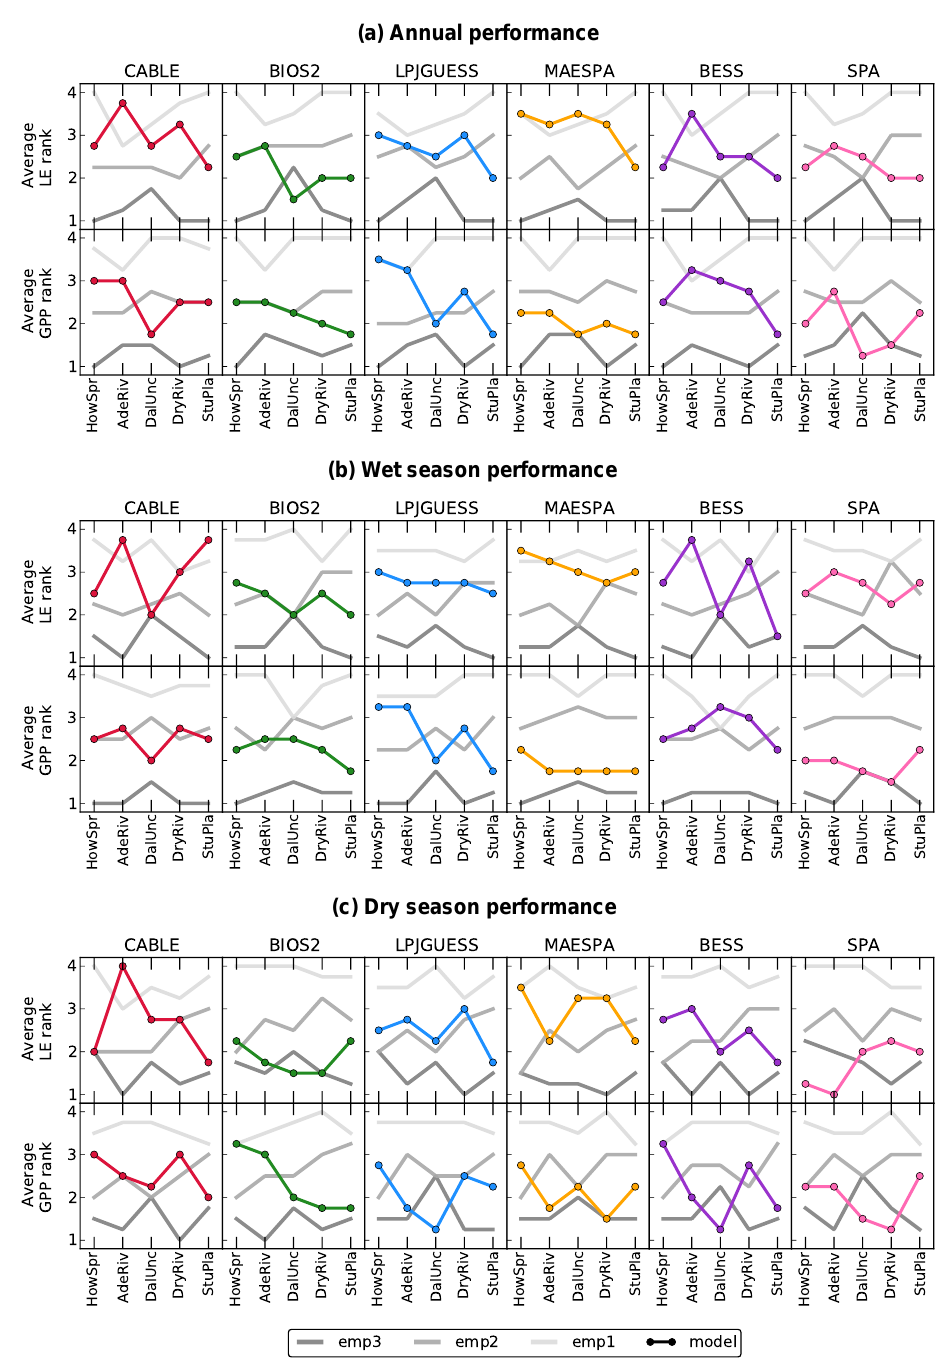
Figure 5. Average rank plot showing the performance of the terrestrial biosphere models for all sites across the North Australian Tropical Transect (NATT) ordered in terms of annual rainfall as follows: Howard Springs (HowSpr), Adelaide River (AdrRiv), Daly Uncleared (DalUnc), Dry River (DryRiv), and Sturt Plains (StuPla). Models are individually ranked against the benchmarks on the order of 1 to 4 (1 model + 3 benchmarks) and express the amount of metrics the models are meeting listed in Table S1. The rankings are determined individually for latent energy (LE) and gross primary productivity (GPP). The coloured lines represent each of the six models in the study, while the grey lines represent the empirical benchmarks. The average ranking for each model was determined for (a) a complete year, (b) the wet season, and (c) the dry